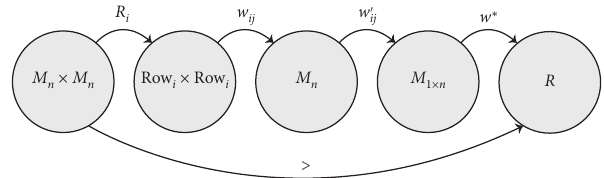
Figure 1: Composition of mapping ≻